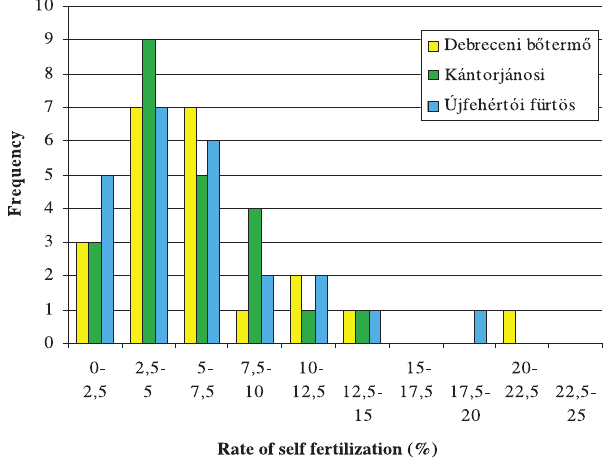
of blooming period at “Kántorjánosi” sour cherry cultivar (Újfehértó, 1983–2008)